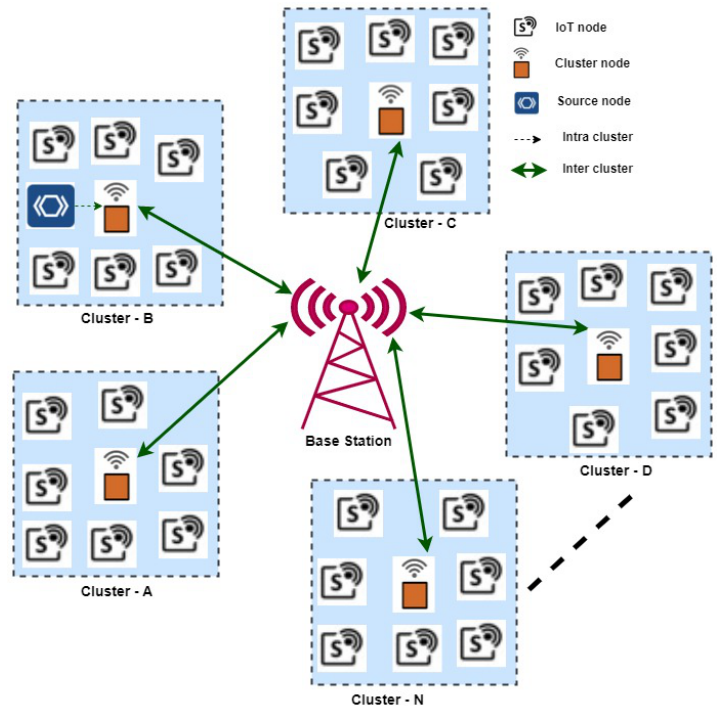
Figure 1. System model of